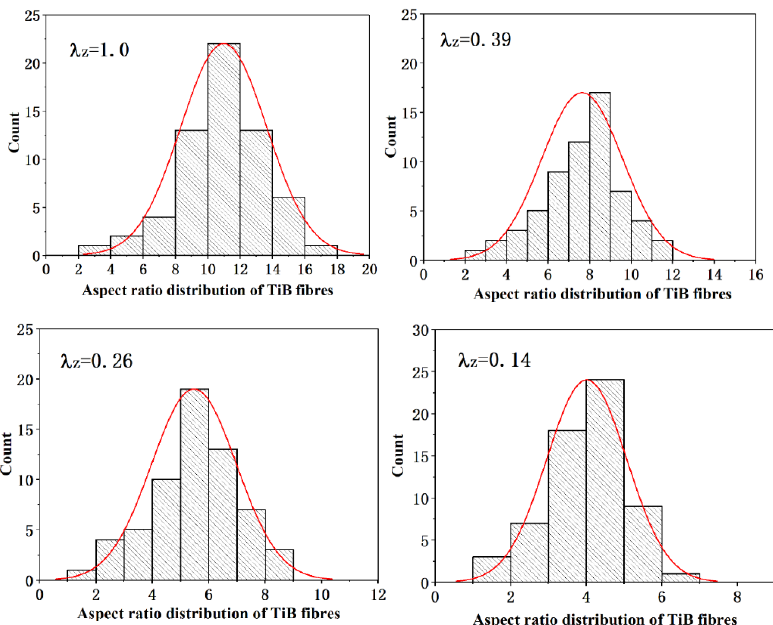
Figure 10. Changes in the aspect ratio of TiB fibers during thermal deformation.